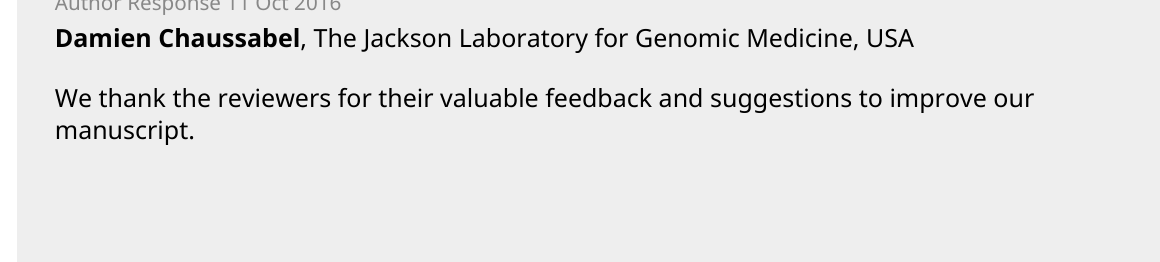
Figure 3: It would be helpful to mark the values for the different individuals, maybe by different colours to avoid the impression of a general outlier. Otherwise, changes after PAMP treatment could be